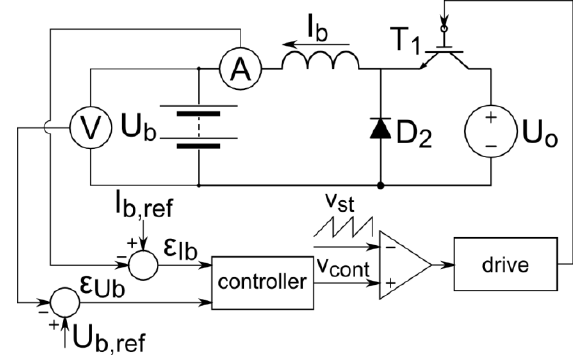
Figure 13. Outline of the feedback voltage control in charge condition.